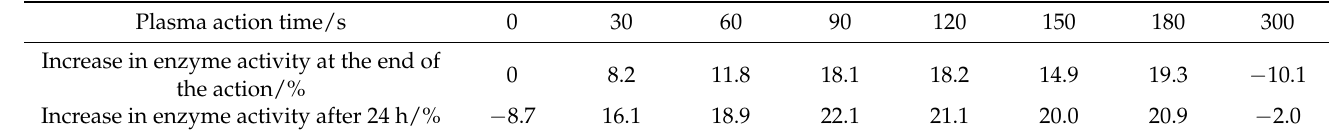
Table 2. The proportion of α -amylase enzyme activity increased by